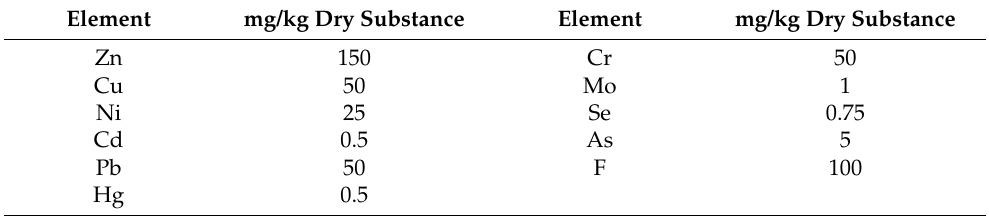
Table 11. Maximum content of elements in polymeric materials.